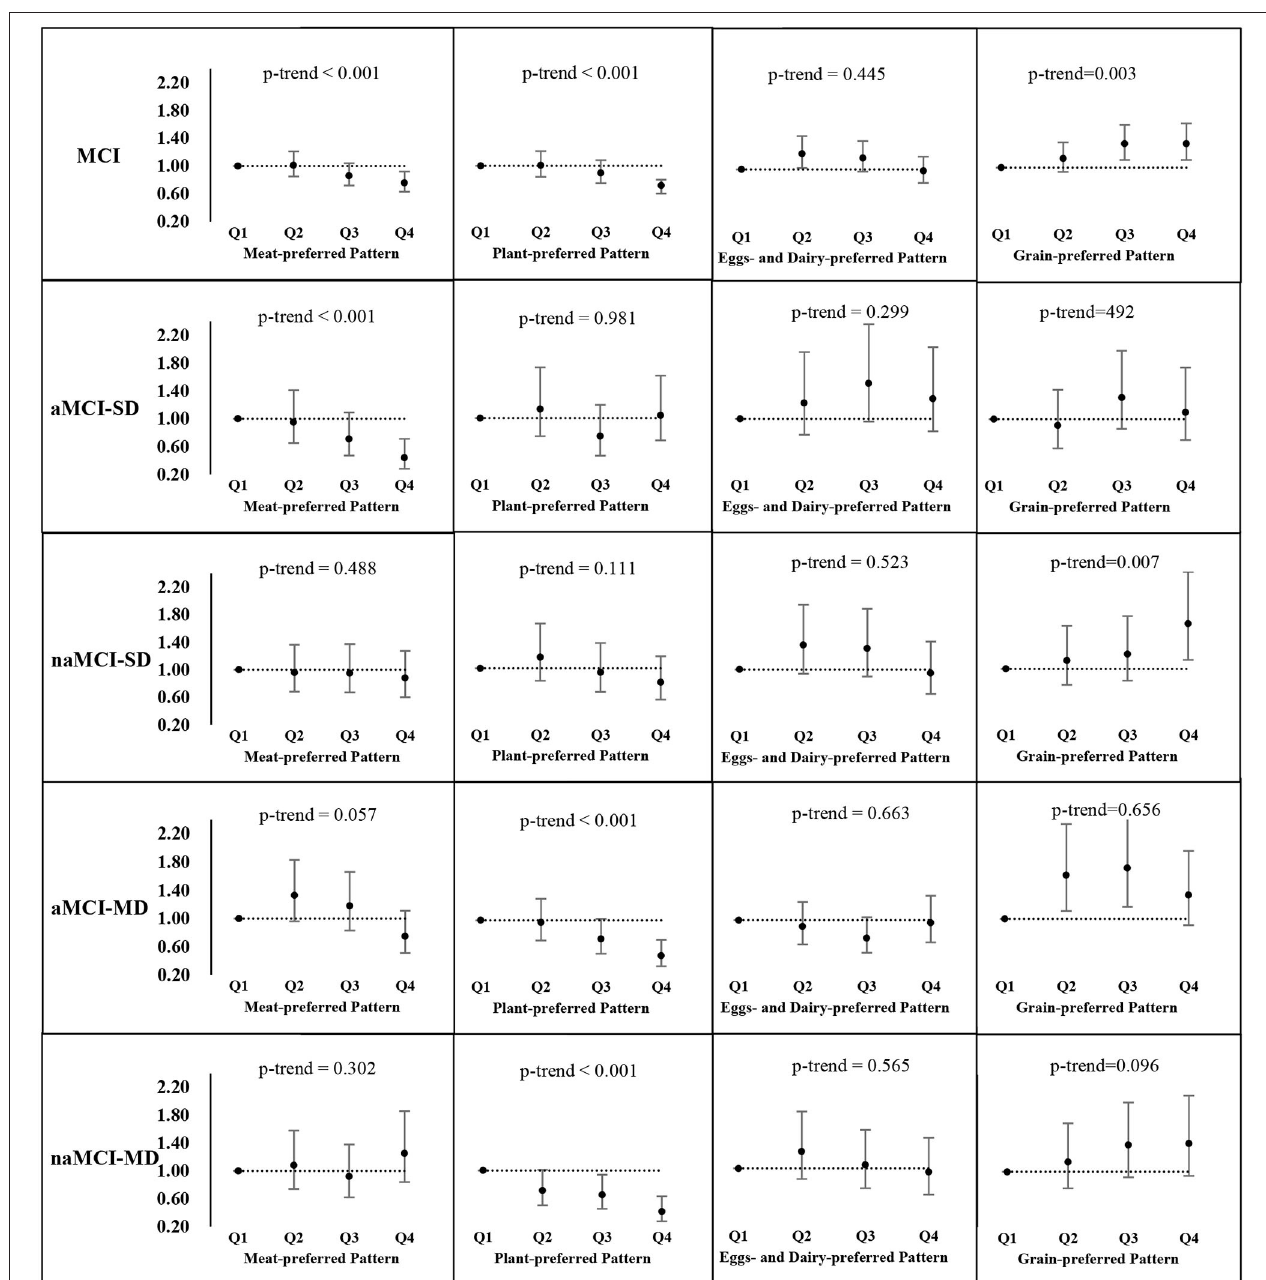
FIGURE 2 | Adjusted odds ratios ( AOR ) and the corresponding 95% CI s for MCI and its subtypes across quartiles of each dietary pattern score a . a MCI, mild cognitive impairment; aMCI-SD, amnestic MCI single domain; naMCI-SD, non-amnestic MCI single domain; aMCI-MD, amnestic MCI multiple domains; naMCI-MD, non-amnestic MCI multiple domains. Adjusted for age, gender, residential area, education level, current employment status, household income level, physical activity, smoking, drinking, sleep duration, total food energy, diet-related chronic disease history, obesity, and central